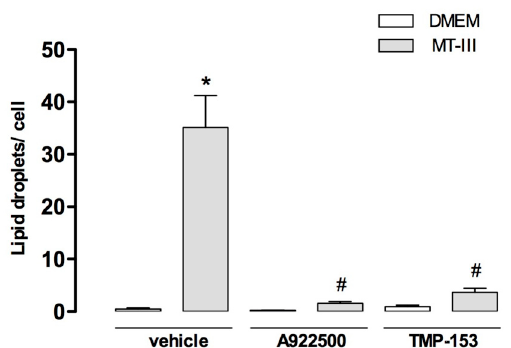
Figure 4. E ff ect of DGAT and ACAT inhibitors on LD formation induced by MT-III. VSMCs (5 × 10 3 cells / well) were incubated with A922500 (100 nM) or TMP-153 (100 nM) or vehicle ( < 1% DMSO or RPMI) for 1 h and then with MT-III (0.4 µ M) for 12 h. LDs were quantified using light microscopy after osmium staining. Each bar represents the mean ± SEM LDs / cell in 50 counted cells. Values represent means ± SEM from three independent experiments ( n = 9) (ANOVA). Note: * p < 0.05 compared with vehicle treated cells; # p < 0.05 compared with vehicle treated cells stimulated with